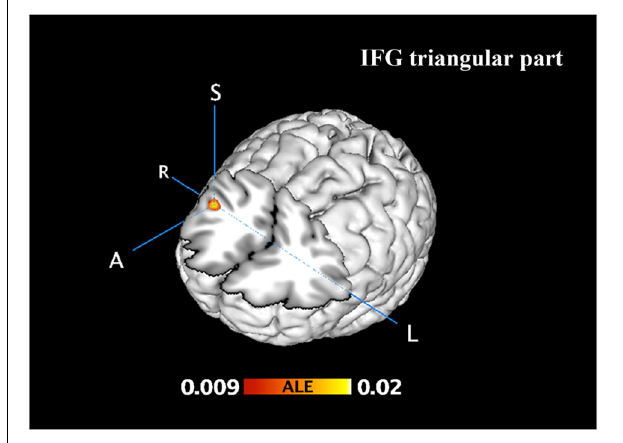
FIGURE 3 | Incongruent activation was greater than neutral and congruent activation. FWE correction at the cluster level ( p < 0.05) with a cluster-forming threshold of p <